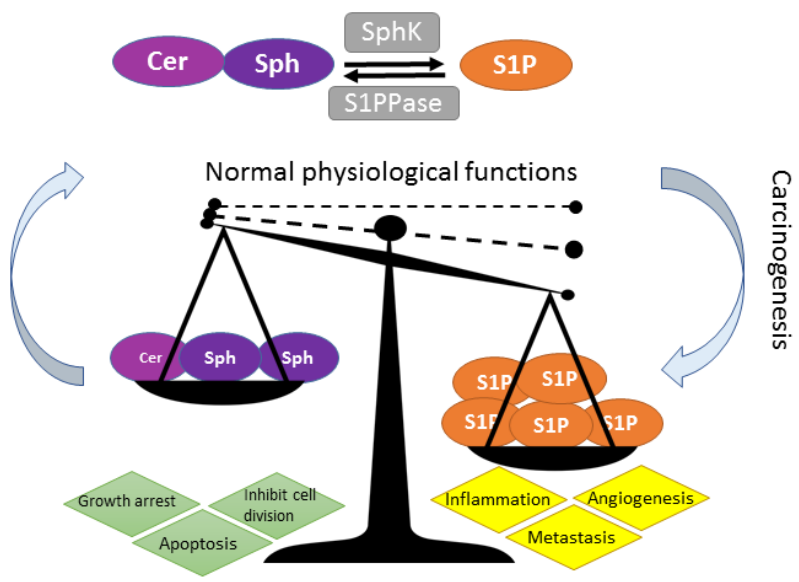
Figure 1. The SphK rheostat: tipping the sphingosine-sphingosine kinase (SphK)-sphingosine-1- phosphate (S1P) rheostat in favor of cancer. Ceramide (Cer) and sphingosine (Sph), upstream in the SphK rheostat, are pro-apoptotic while SphK conversion of sphingosine to S1P tips the balance in favor of cell survival and cell maintenance (as shown by the arrows and dashed lines). Imbalance (increase) in S1P expression, through overexpression of SphK activity, illustrated by dashed lines to solid line, is causally associated with cancer development, inflammation, angiogenesis and metastasis [1].